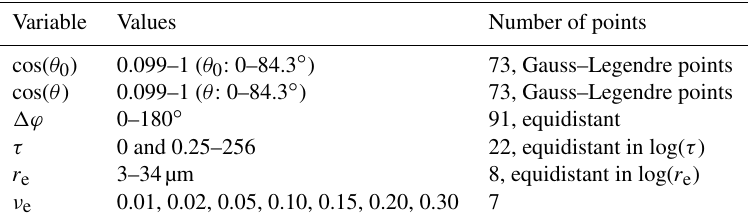
Figure 2. Normalized droplet size distributions for r e = 12µm, for the seven values of effective variance ν e used in the Mie and DAK calculations (a) and corresponding scattering phase functions for λ = 0 . 6µm derived from Mie calculations (b) . Table 1. Values and numbers of points of the variables comprising the five dimensions of the cloud reflectance LUTs. Each value of effective variance ( ν e , last row) corresponds to a different